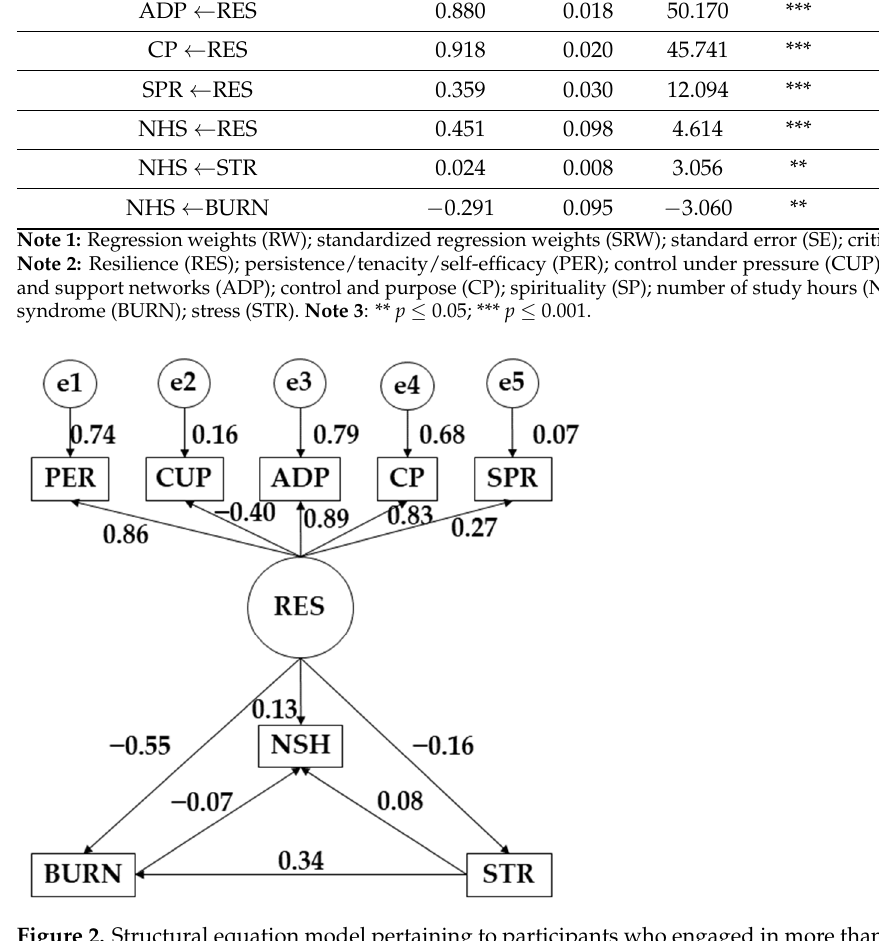
Figure 2. Structural equation model pertaining to participants who engaged in more than 3 h of physical activity a week. Note: Resilience (RES); persistence/tenacity/self-efficacy (PER); control un- der pressure (CUP); adaptability and support networks (ADP); control and purpose (CP); spiritual- ity (SP); number of study hours (NSH); burnout syndrome (BURN); stress (STR). Table 2. Values obtained from the proposed structural equation model for participants doing more than 3 h of physical activity per week.